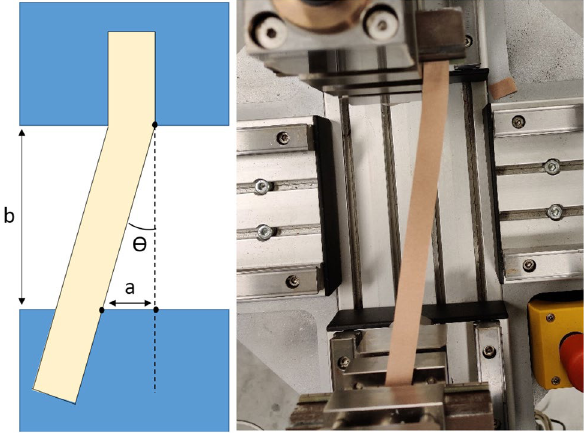
Fig. 5 Top view of test specimen clamped under angle